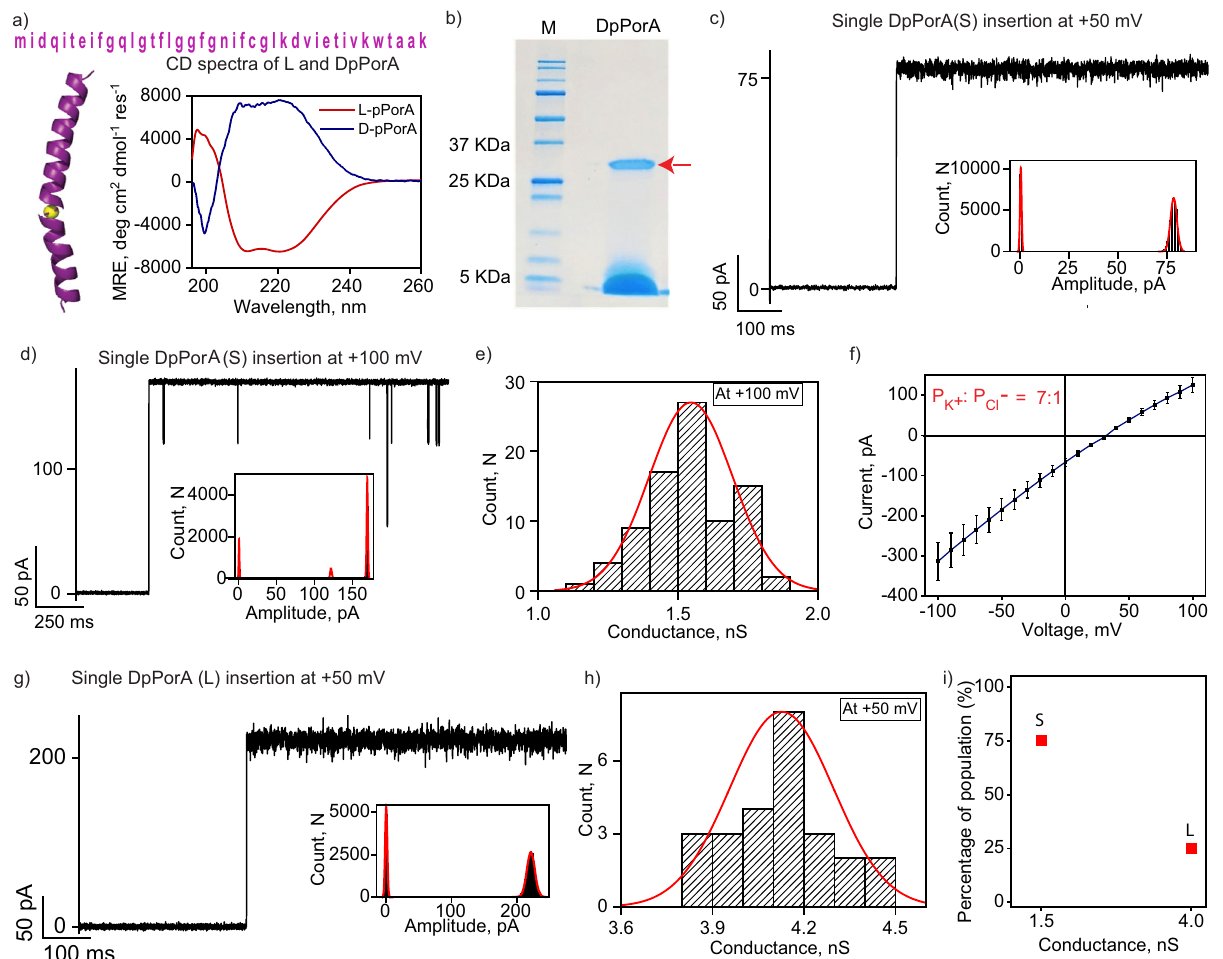
Fig. 1 | Functional assembly and electrical properties of DpPorA. a DpPorA peptide sequence and CD spectra for 100 μ M DpPorA (blue) and LpPorA (red) in phosphate-buffered saline with 1% DDM . b DpPorA peptides run on SDS-PAGE showing self-assembled preoligomers (red arrow) and monomers. Data are repre- sentative of more than fi ve repeats. c Single DpPorA insertion (S) at +50mV and corresponding current amplitude histogram. d Single DpPorA insertion (S) at +100mV and corresponding current amplitude histogram. e The mean unitary conductance histogram for DpPorA insertion events (S) at +100mV was obtained by fi tting the distribution to a Gaussian (number of insertion events, n =75). f I – V